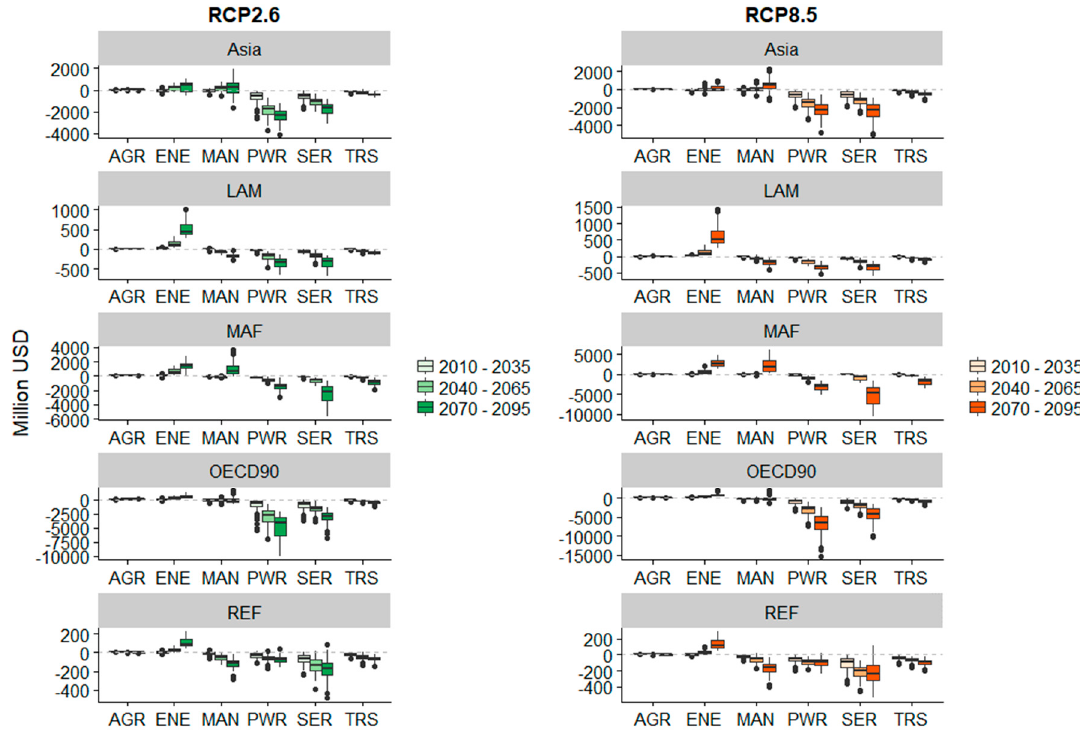
Figure 7. Industry-wise change in value added for the RCP2.6 and RCP8.5 runs. AGR, agriculture; MAN, manufacturing and construction; ENE, energy extraction; SER, service; PWR, power; TRS, transport and communication.